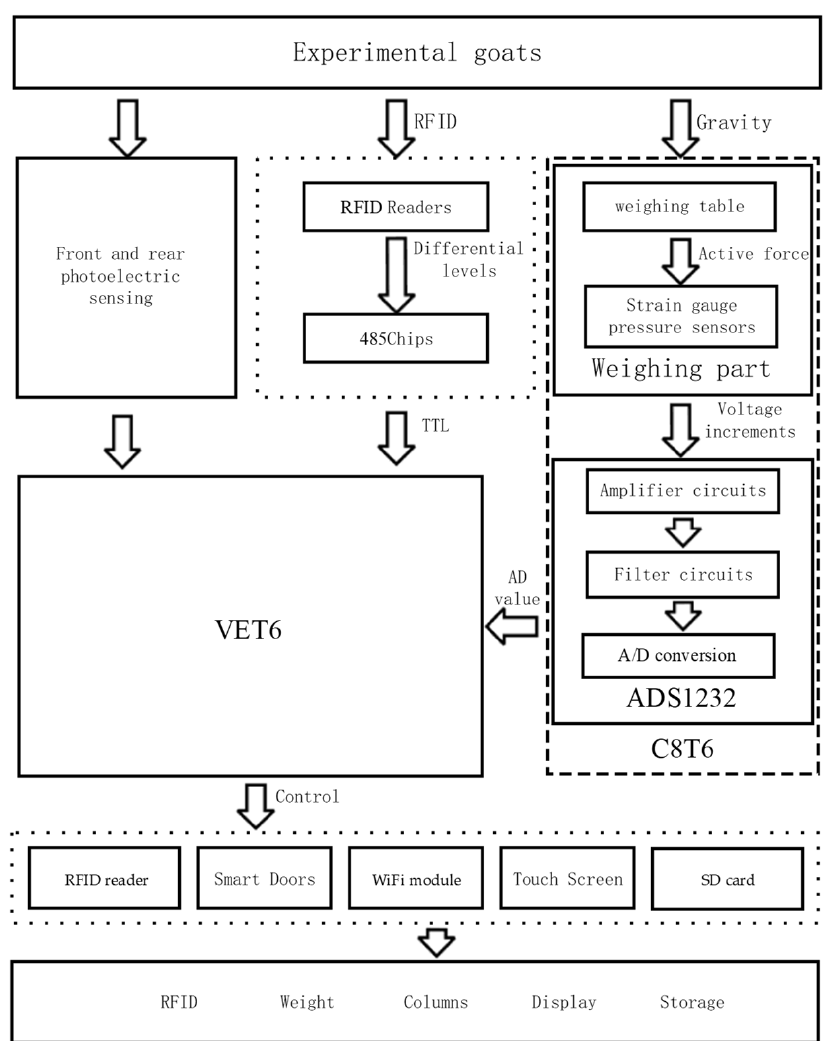
Figure 1. Work fl ow diagram for the channel-type sheep dynamic weighing system. Figure 1. Workflow diagram for the channel-type sheep dynamic weighing system.